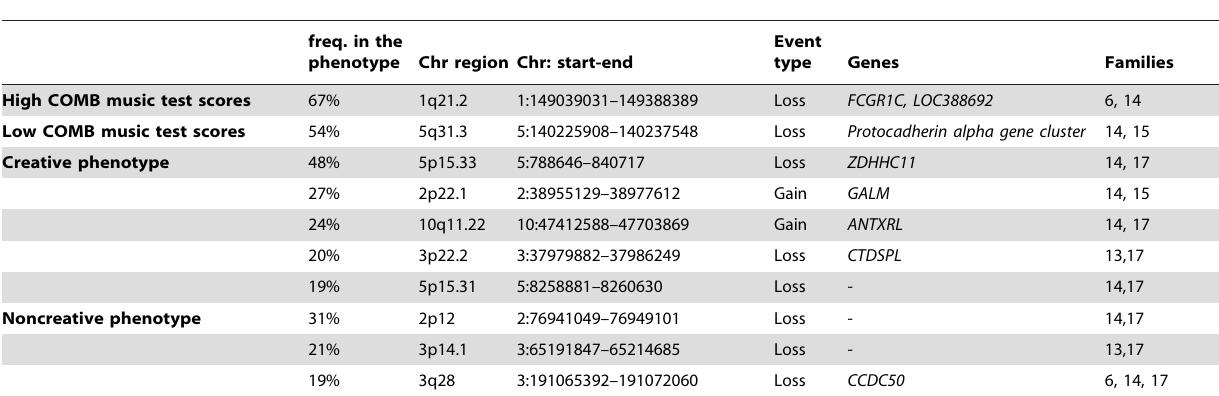
Table 3. High-ranked CNVRs for COMB scores and creative phenotype in the analyzed